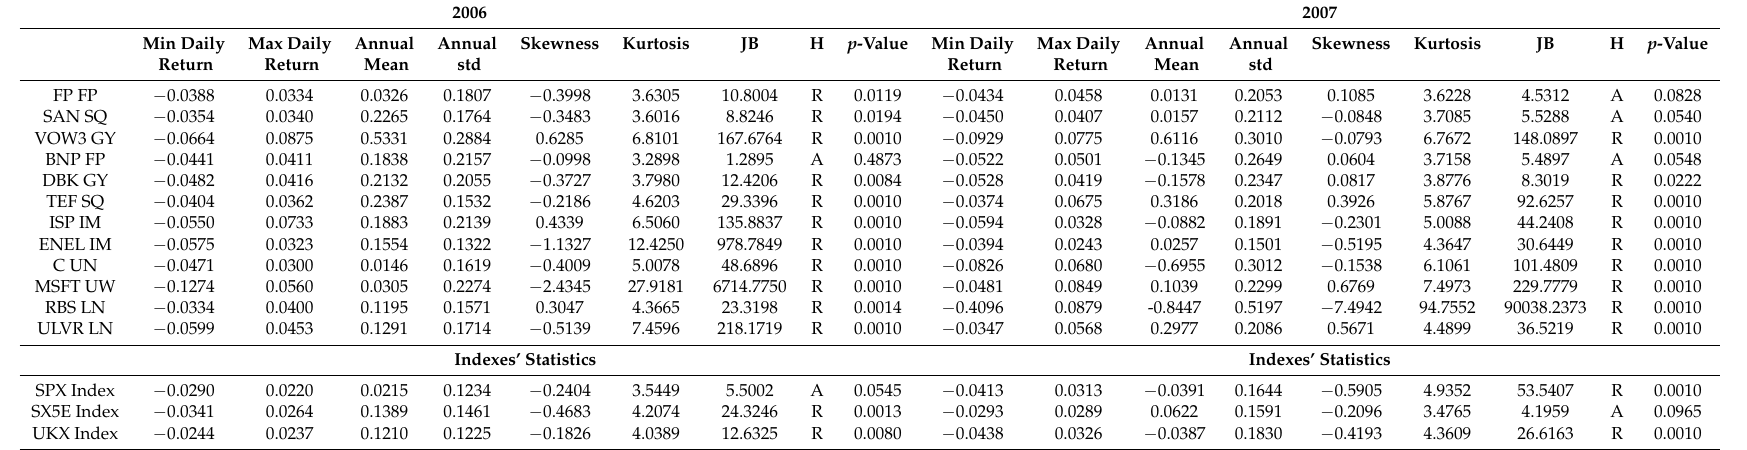
Table A1. Annual descriptive statistics for the equities and indexes in each year under analysis. The dataset includes 12 stocks belonging to the S&P500, the FTSE 100, and the EURO STOXX 50. The dataset contains six 1-year windows from January 2006 to December 2011. For each stock and index, we report the minimum daily return, the maximum daily return, the annual mean (the average daily return is annualized), the annual standard deviation (the daily standard deviation is annualized), skewness, kurtosis, the Jarque–Bera (JB) test statistic, and its null hypothesis h ( h = A if H 0 is accepted and h = R